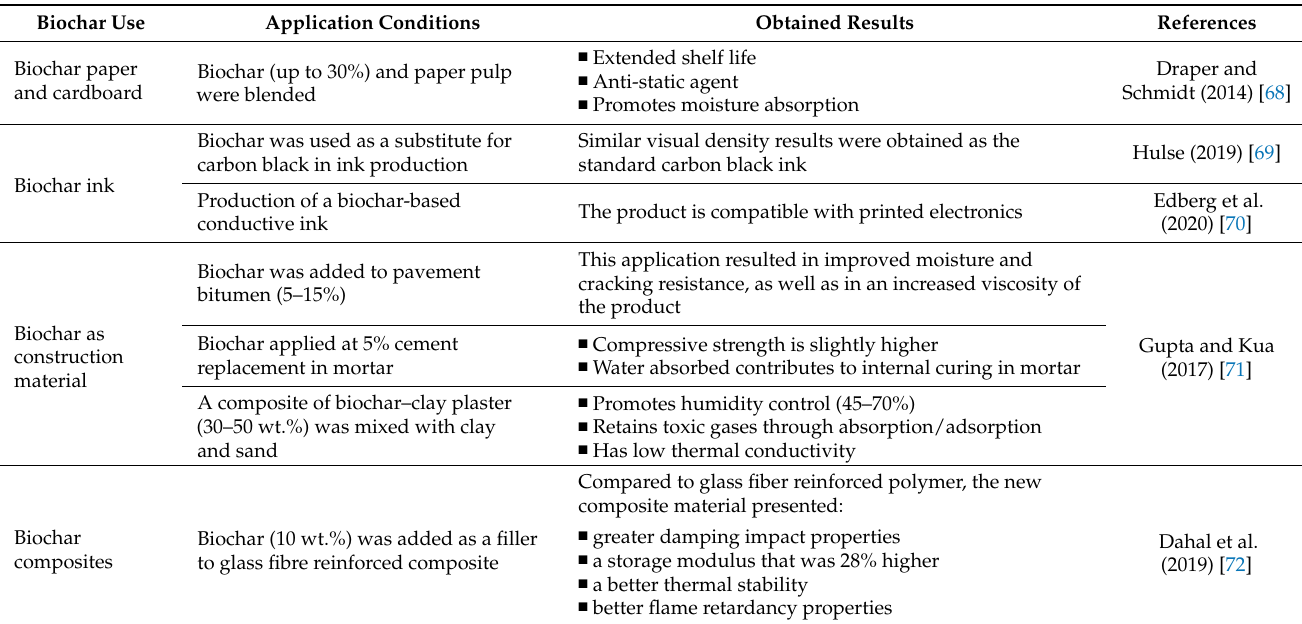
Table 6. List of studies focused on emerging biochar